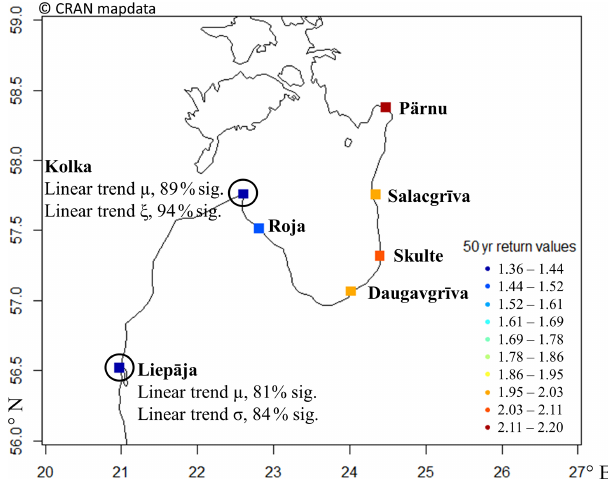
Figure 8. Fifty-year return values (color scale; numbers indicate the range in meters) obtained with a stationary-GEV function fit (squares). The tide gauges with a linear trend in one of the GEV parameters are marked with large black